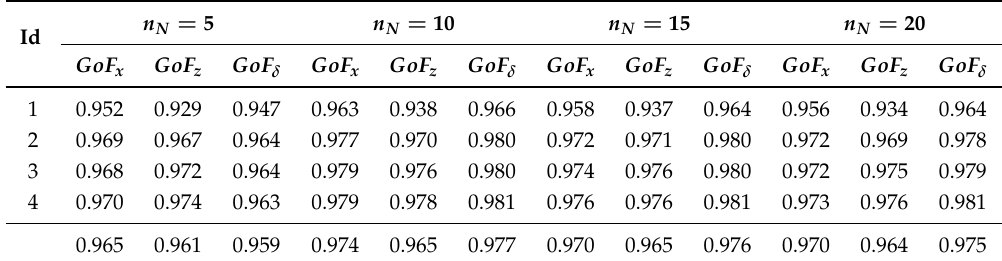
Table 5. GoF results of the NN model for each tuning wave for different neurons n N . The delay steps are fixed to 3. The last row stores the mean